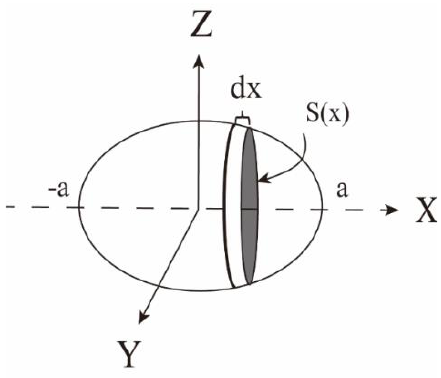
Figure 6. Schematic diagram of the volume of an ellipsoid.